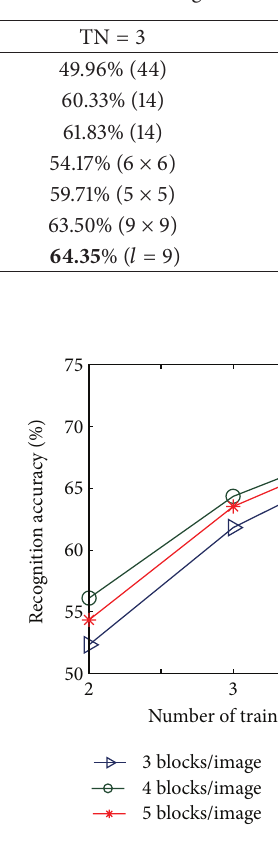
Table 2: Face recognition accuracies of different methods on the Yale database. TN means number of training samples per subject, and the number in brackets is the corresponding projection dimensionality. The bold value means the highest accuracy among all the methods.